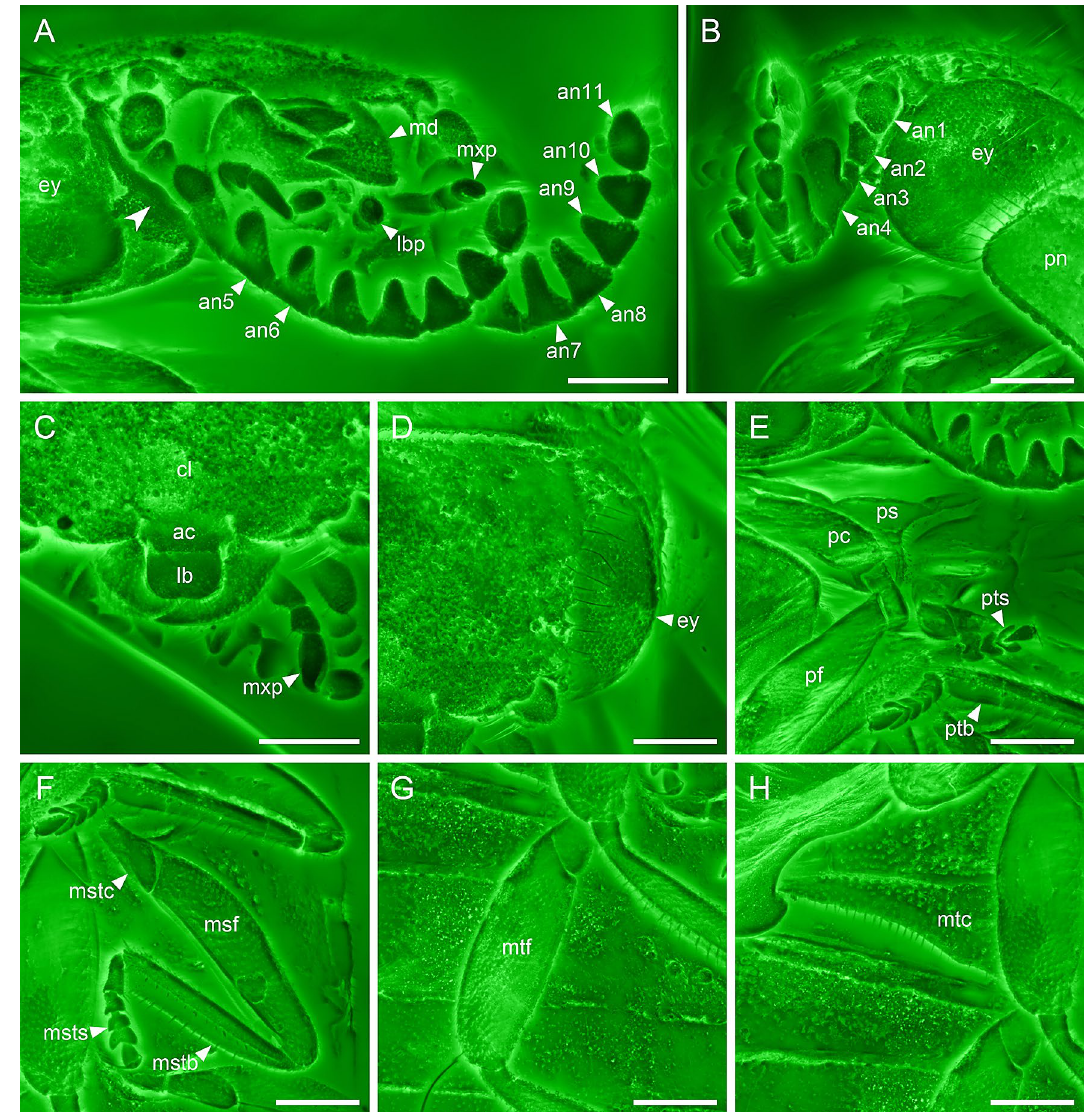
Figure 2. Details of Varcalium lawrencei gen. et sp. nov. , holotype, NIGP177336, under confocal microscopy. ( A ) Head, anterolateral view. ( B ) Head, lateral view. ( C ) Mouthparts, dorsal view. ( D ) Head, dorsal view. ( E ) Prothorax, ventral view. ( F ) Mid legs. ( G ) Metafemur. (H) Metacoxa. Abbreviations: ac, anteclypeus; an1–11, antennomeres 1–11; cl, clypeus; ey, compound eye; lb, labrum; lbp, labial palp; md, mandible; msf, mesofemur; mstb, mesotibia; mstc, mesotrochanter; msts, mesotarsus; mtc, metacoxal; mtf, metafemur; mxp, maxillary palp; pc, procoxa; pf, profemur; pn, pronotum; ps, prosternum; ptb, protibia; pts, protarsus. Scale bars: 200